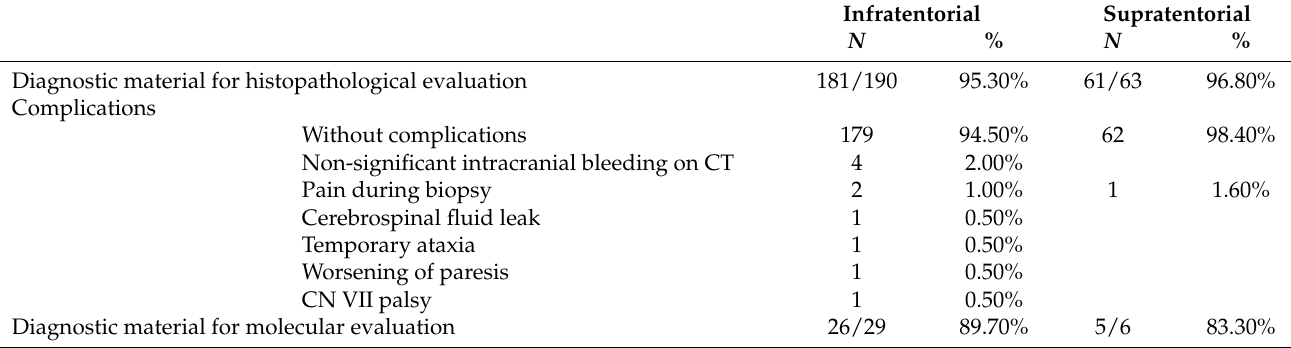
Table 5. Comparison of safety and efficacy between supratentorial and infratentorial approaches.